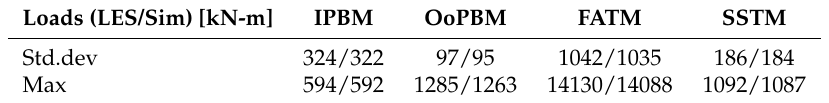
Table 14. Turbine load statistics in the free stream: Large Eddy Simulation (LES) vs. stochastic model. Loads (LES/Sim) [kN-m] IPBM OoPBM FATM